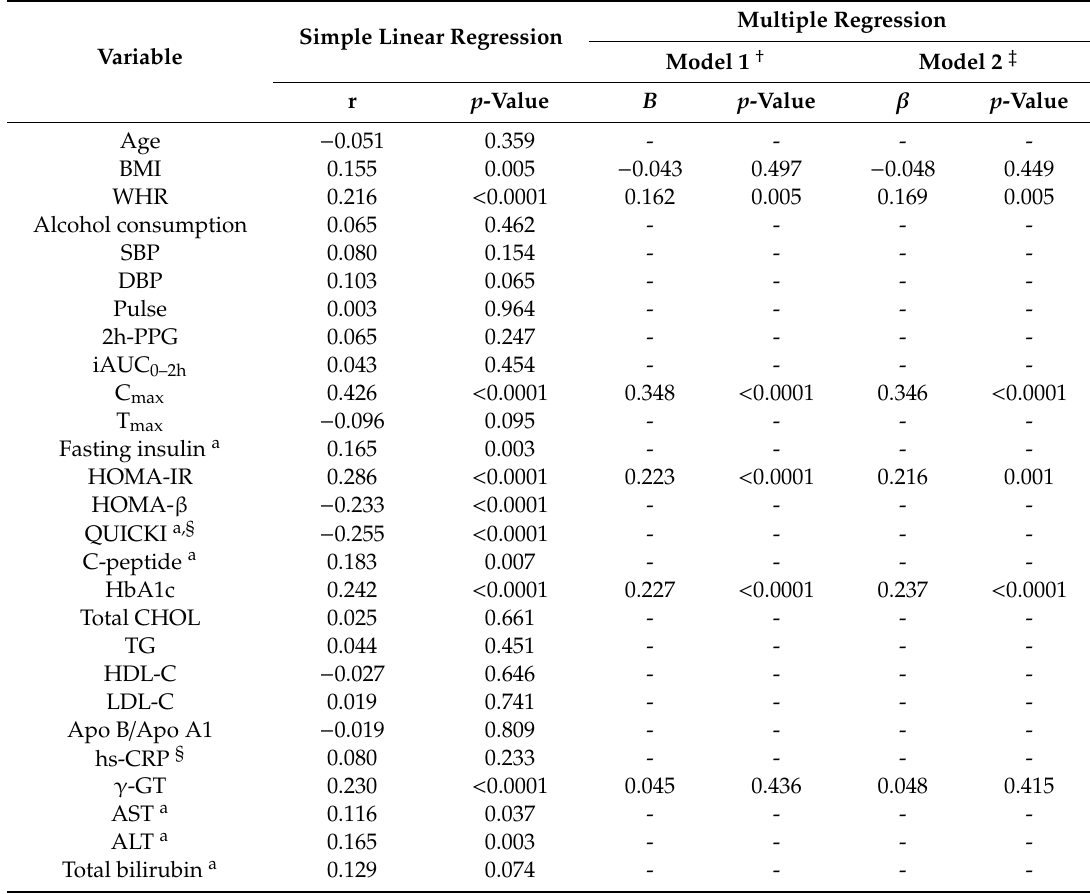
Table 4. Factors related to elevating FPG levels in subjects with